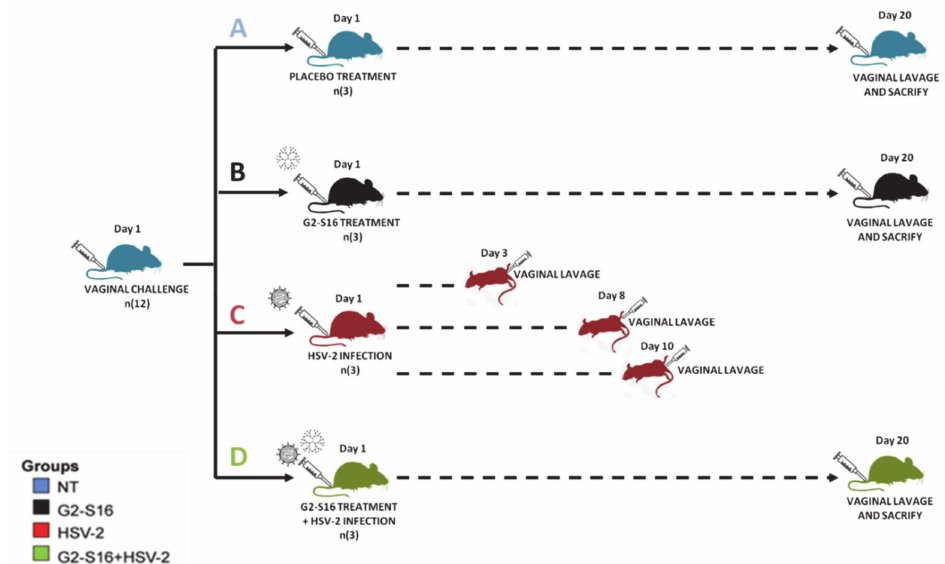
Figure 1. Schematic representation of experimental design and samples. Four mice groups (3 mice per group) were analyzed and vaginal lavages were collected at day 1 and day 20. Group NT (healthy untreated; samples ( A ), Group G2-S16 (treated with dendrimer; samples ( B ), Group HSV-2 (infected with HSV-2; samples C ) that was sampled prior infection and post-infection, when a mouse reached a 4 diseases score (between days 3–10) and Group G2-S16 + HSV-2 (treated with dendrimer and post-infected with HSV-2; samples D